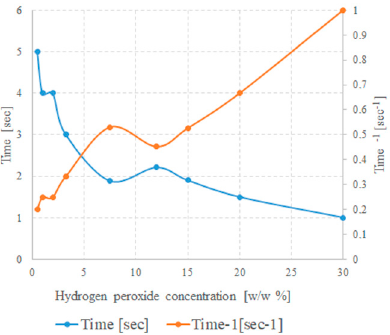
Figure 3. Dependence of time of appearance of the first bubbles at surface of metallic pieces and its inverse as a function of concentration.